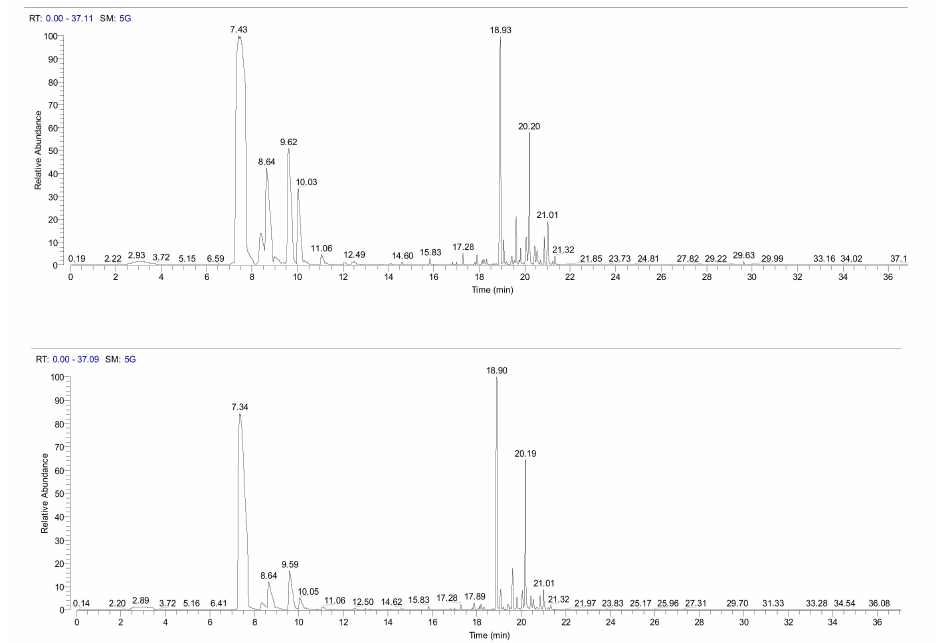
Figure 1. A typical headspace-GC / MS chromatogram obtained from Calabrian pine needles collected at Bova. Upper panel, plant infested by the pine processionary moth; lower panel, not infested (control) plant.